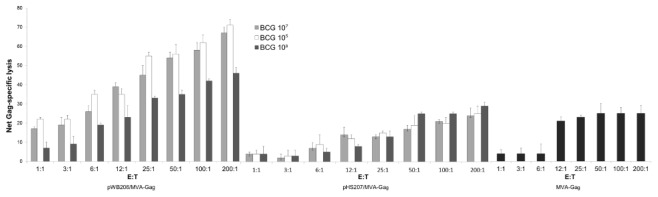
CTL responses measured in a 51Cr release assay.Splenocytes pooled from a group of 5 mice on day 68 after a prime with BCG[pWB206] or BCG[pHS207] (107 CFU, 105 CFU, 103 CFU) or no prime and boost with MVA-Gag (107 pfu) on day 56, were stimulated with the GagCD8 peptide for 6 days. Generated effector cells were used in a 51Cr release assay using p815 antigen presenting cells in the presence and absence of peptide. Data values indicate the mean net percentage Gag-peptide specific lysis ± the standard deviation (n = 3), calculated after the background lysis (<10%) in the absence of peptide has been subtracted. Net Gag-specific lysis was considered positive if >10% and are shown.